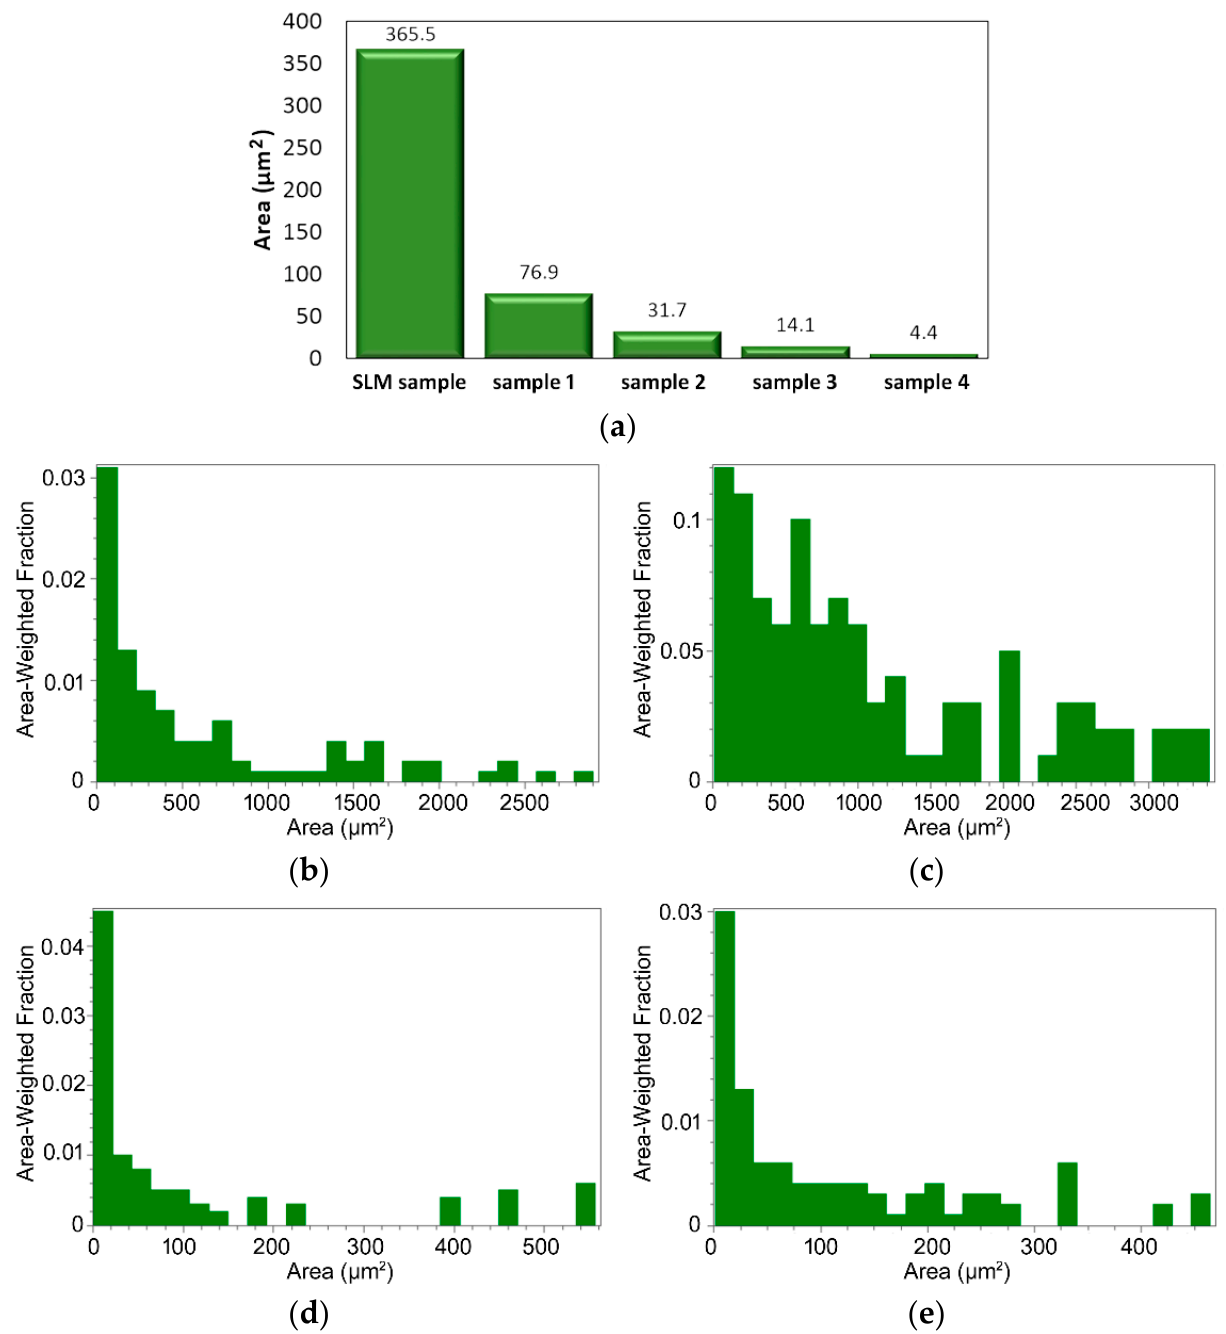
Figure 3. Average grain areas for the examined samples ( a ). Grain area distributions for: sample 1 peripheral region ( b ); sample 1 axial region ( c ); sample 4 peripheral region ( d ); sample 4 axial region ( e ). The 3D-printed material consisted of a mixture of large and small grains, i.e., a bimodal structure. Many of the grains were elongated along a single direction (Figure 2a),